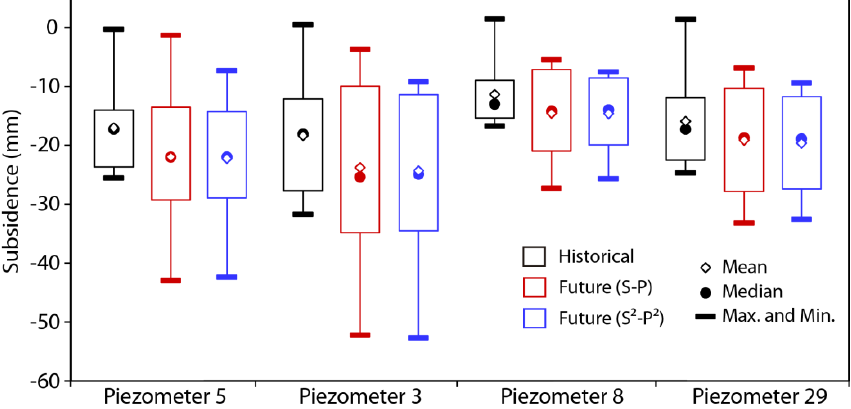
Figure 10. Historical and future subsidence for the two best linear regression models (S = a × P + b; S² = a × P² + b).